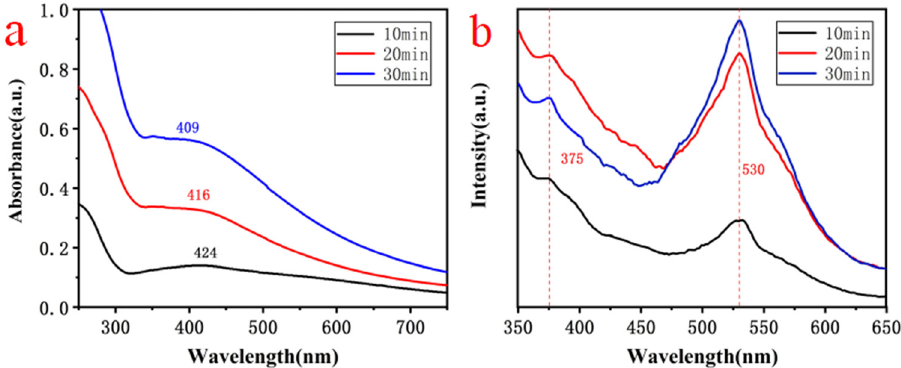
Figure 5: ( a ) UV - Vis spectra and ( b ) fl uorescence emission spectra of as - prepared CQDs/mesoporous SiO 2 /Ag NPs composites in photo - chemical reactor for di ff erent UV irradiating time.